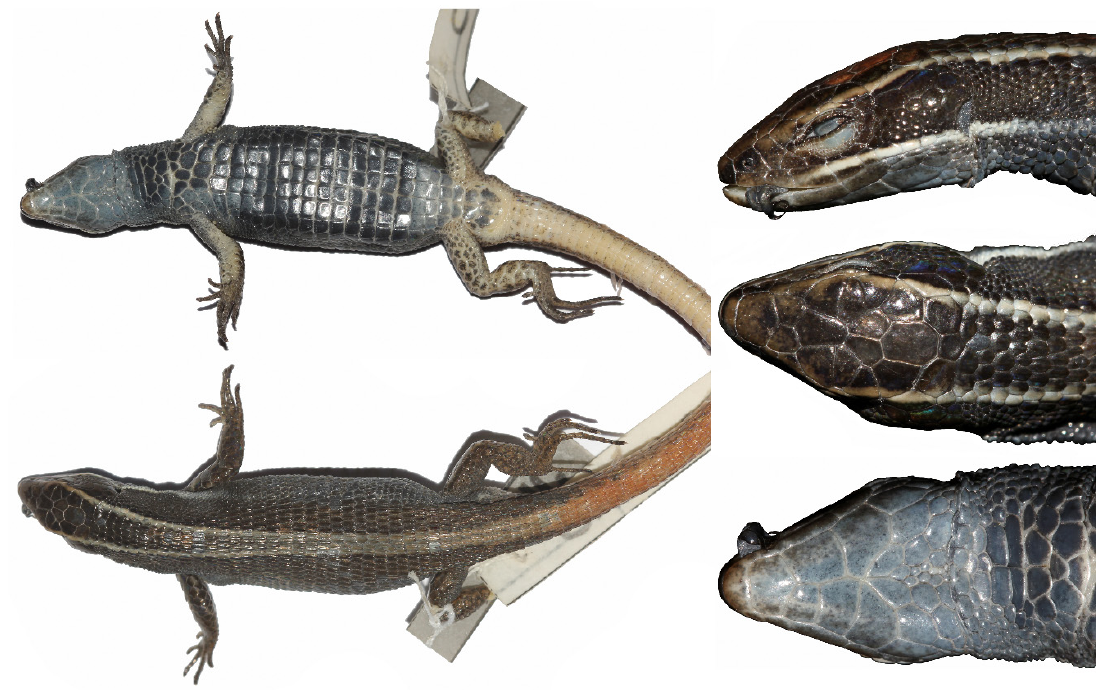
Figure 6. Holotype of Cercosaura pacha sp. nov. female MUBI 14515 (SVL = 49.7 mm). Paratype: MUBI 14512 (Figure 7), a subadult female from near the type locality (10°23 ′ 29 ″ S, 75°34 ′ 12 ″ W, 1845 m).